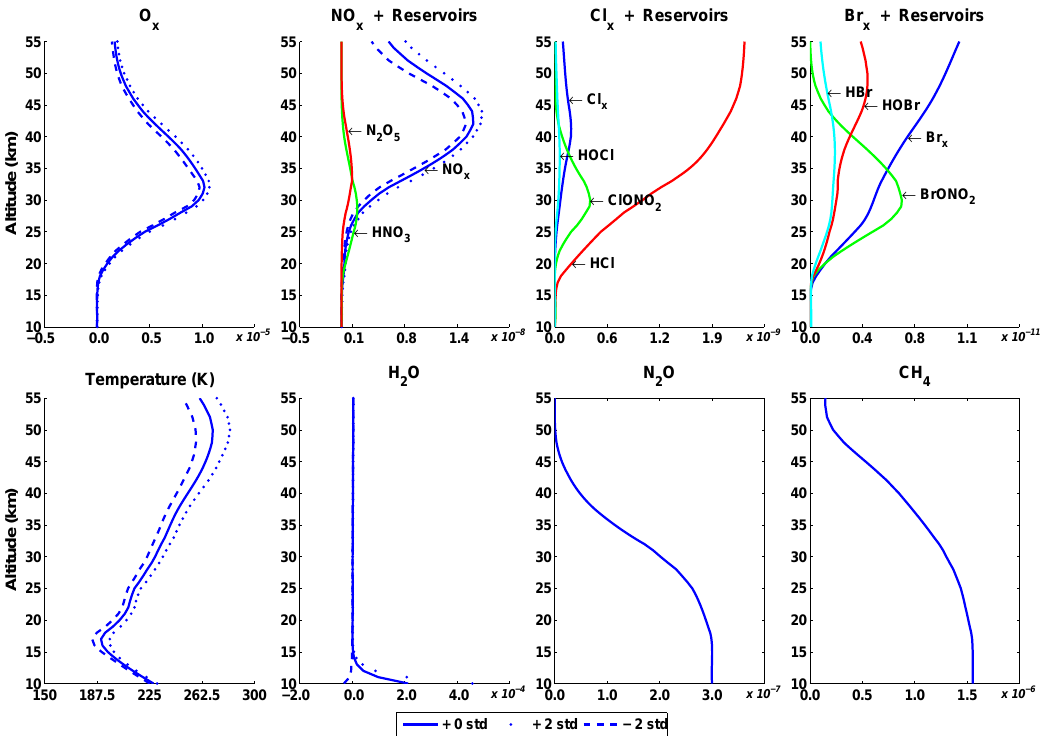
Fig. 1. Initial conditions used in the simulations for the interactive species (upper row) and the specified temperature and species (lower row) that vary with altitude. Initial conditions for specified species that have a constant mixing ratio with altitude are provided in Table 1. Solid lines of different colours correspond to regular initial conditions, while the dashed and dotted lines represent the two-standard deviation perturbed initial conditions used in the simulations testing the sensitivity to the initial conditions (see text for more details). Chemical species are shown in units of volume mixing ratio, and the temperature in